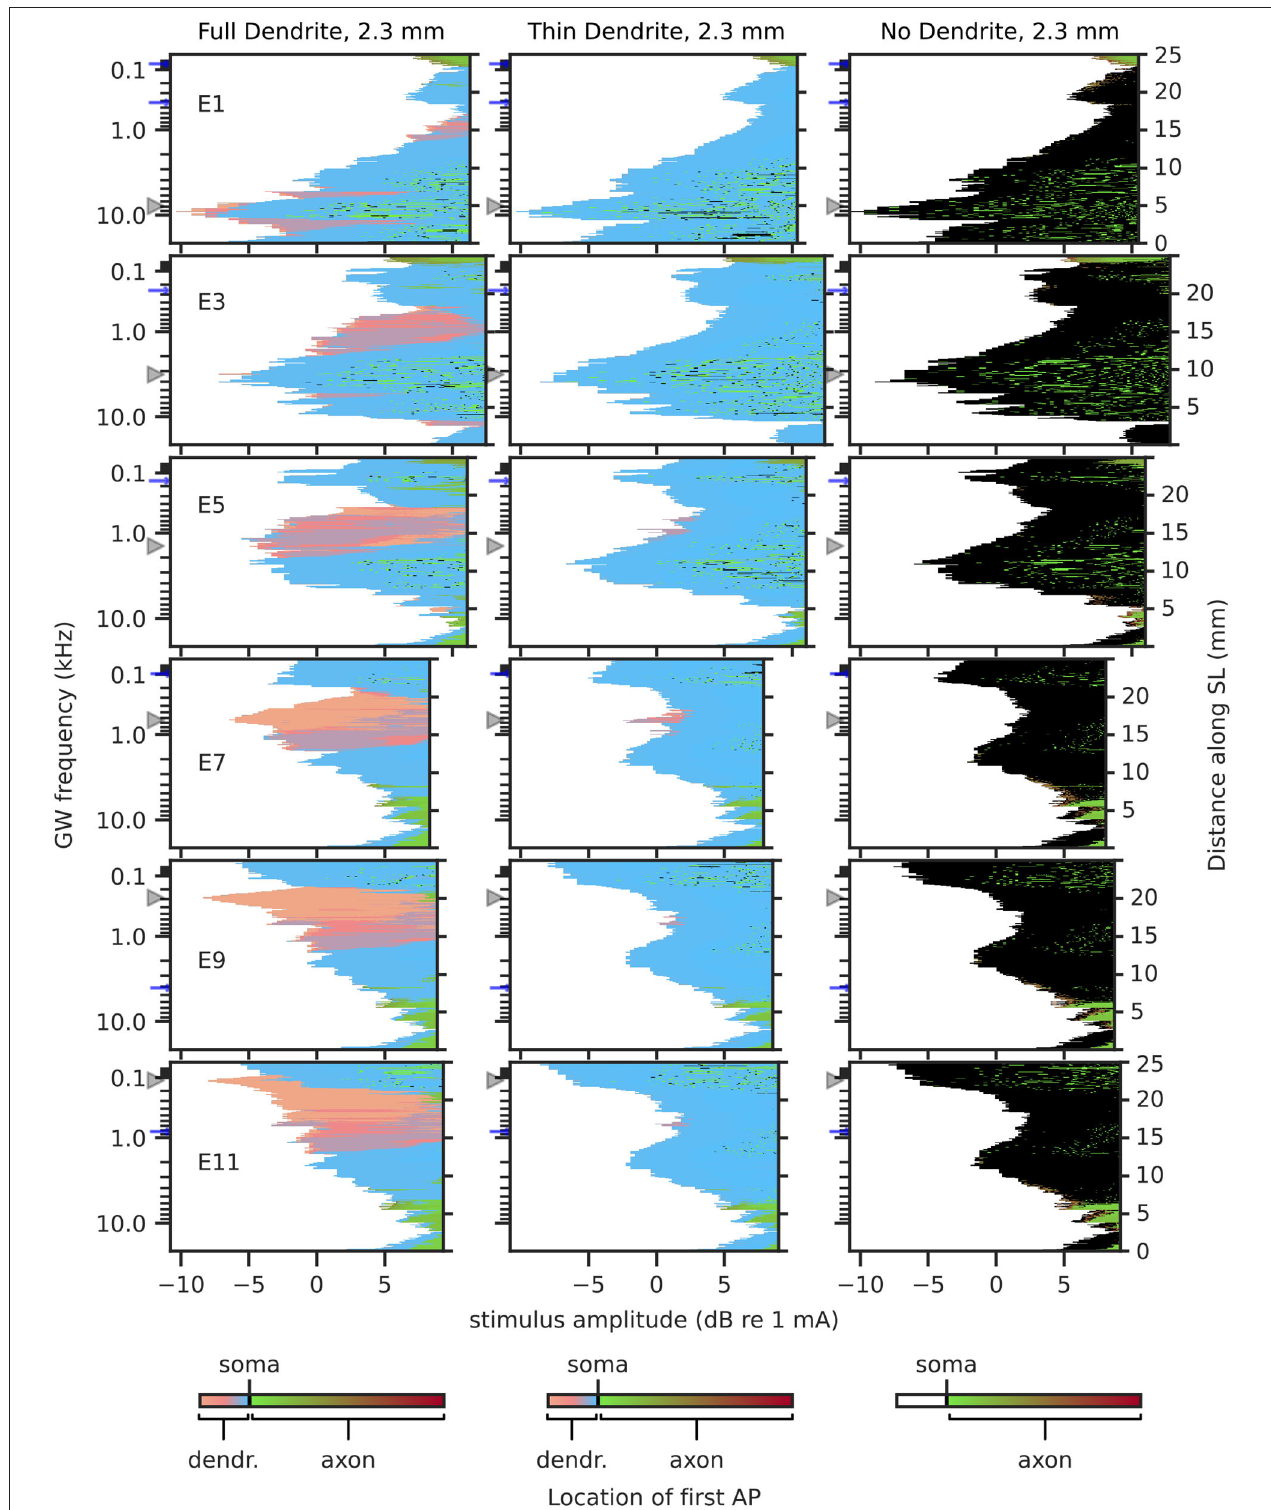
FIGURE 7 | Excitation profiles for 2.3mm dendrites. Greenwood frequency mapping performed for all 400 fibers, marked on the left ordinate. Fiber position along spiral lamina marked on the right ordinate. AP initiation site is color-coded, soma marked with black color. Stimulation electrodes labeled on the left. Electrode position is mapped to its nearest fiber and indicated by gray triangles, blue arrows mark fibers at ± 360 ◦ to the stimulation electrodes.